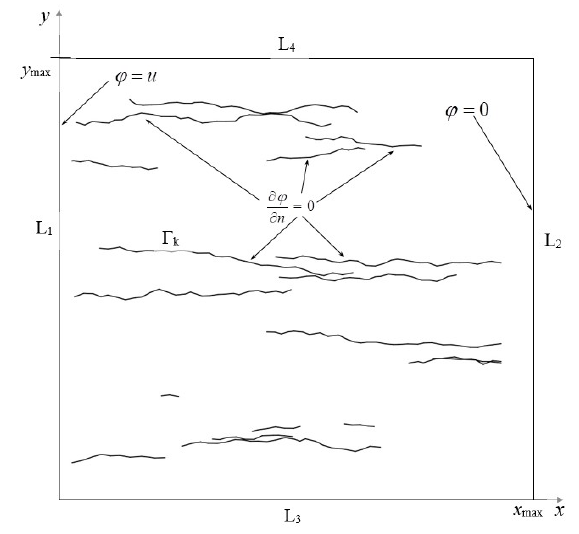
Figure 2. The analyzed model of a conductive layer with line defects.